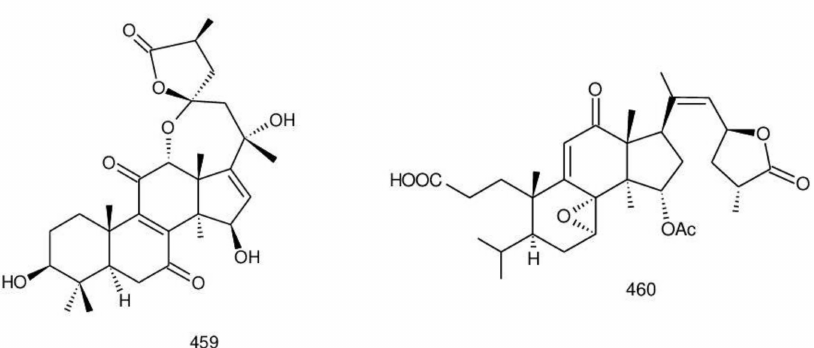
Figure 23. Chemical structures of polyoxygenated lanostane triterpenoids: austrolactone ( 459 ) and australic acid ( 460 ).